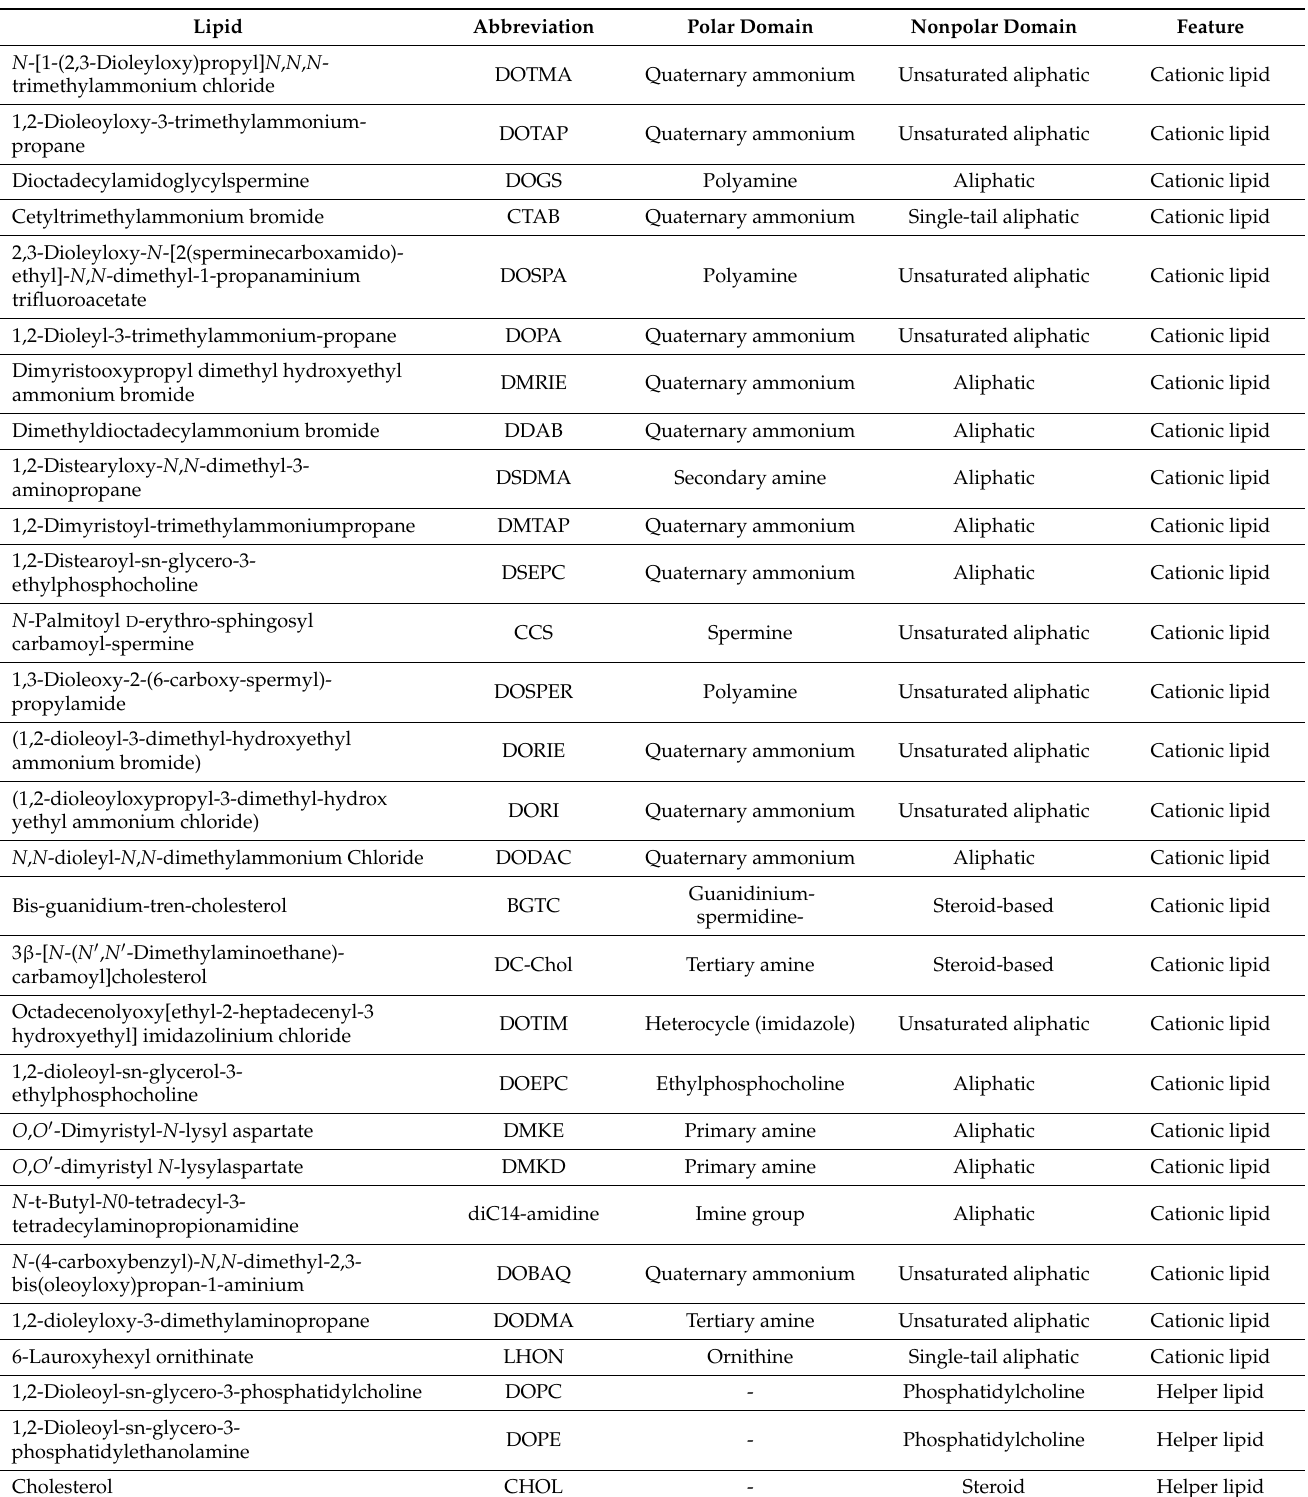
Table 2. Lipids commonly used for gene